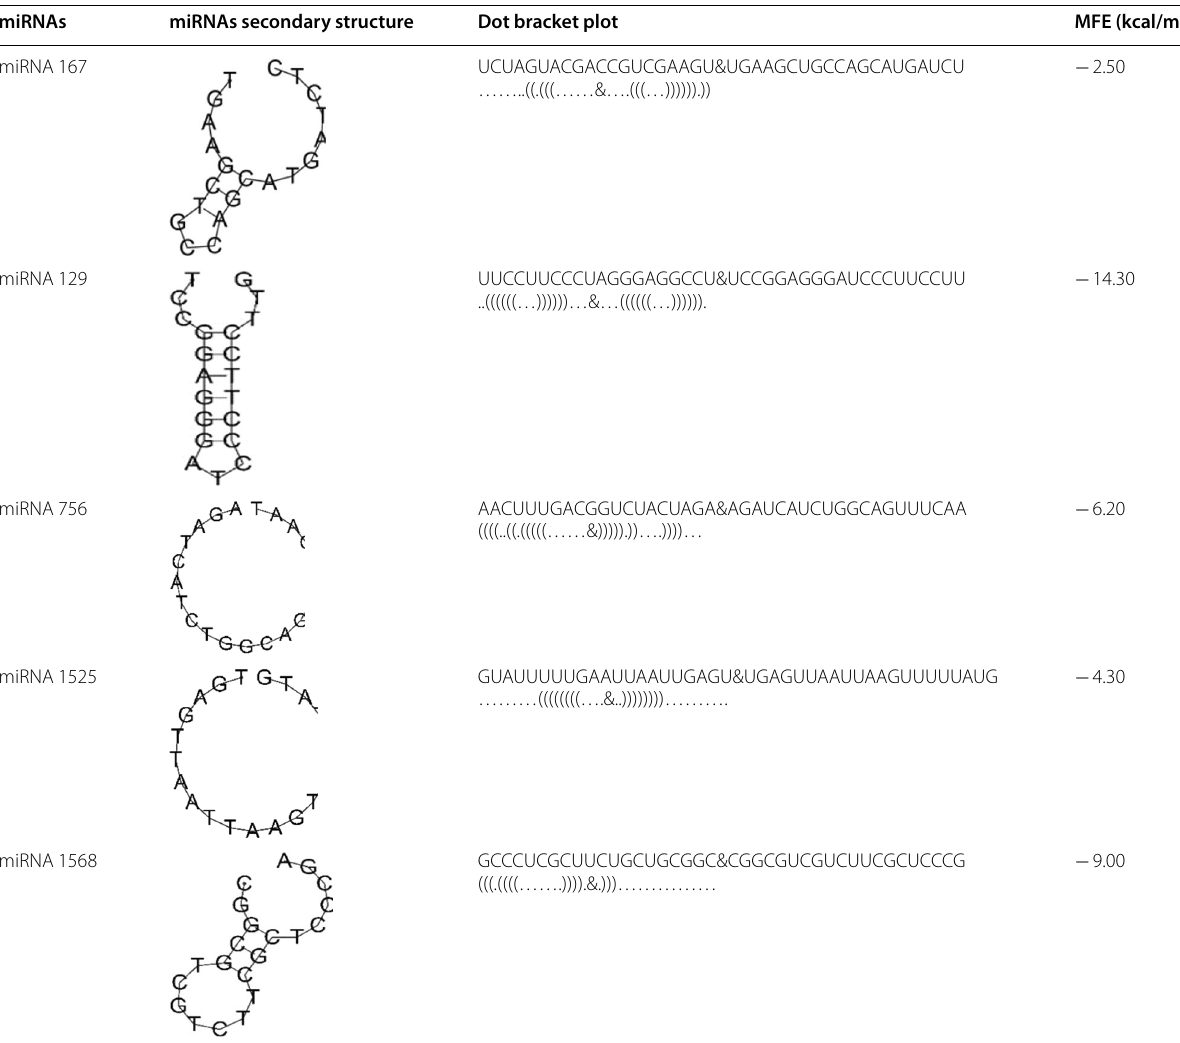
Table 4 The prediction of secondary structure prediction of miRNAs using RNAcofold miRNAs